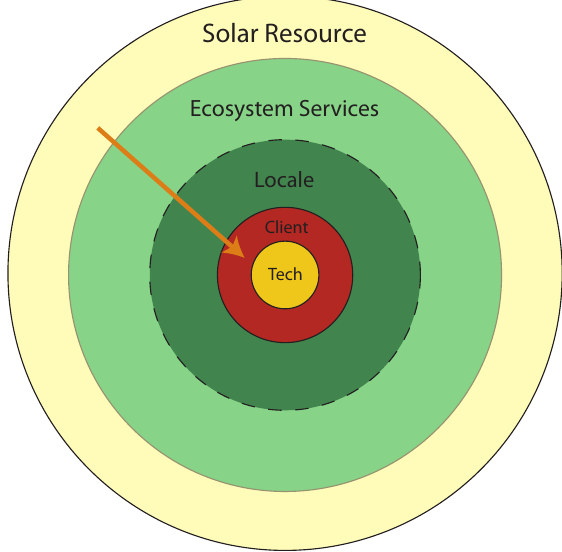
Figure 1. Schematic of the solar ecology tied to the central technologies of a SECS. Three center rings reflect interactions among solar technology (core), client, and locale particular to the goal of solar design: to maximize the solar utility for the client in a given locale.